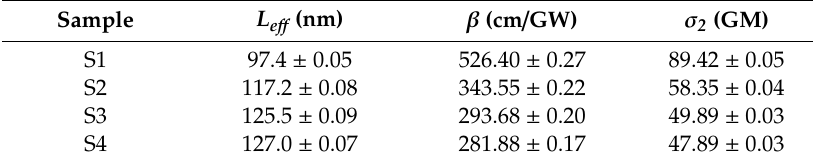
Table 4. Nonlinear optical absorption (NOA) parameters of the Ta-doped InTe thin films measured by OA